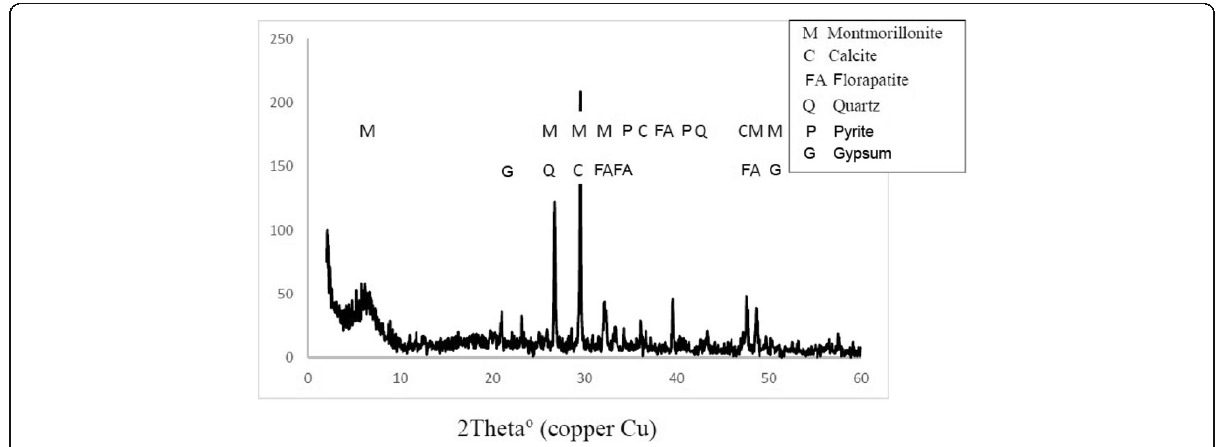
Fig. 3 XRD pattern of raw clay technological